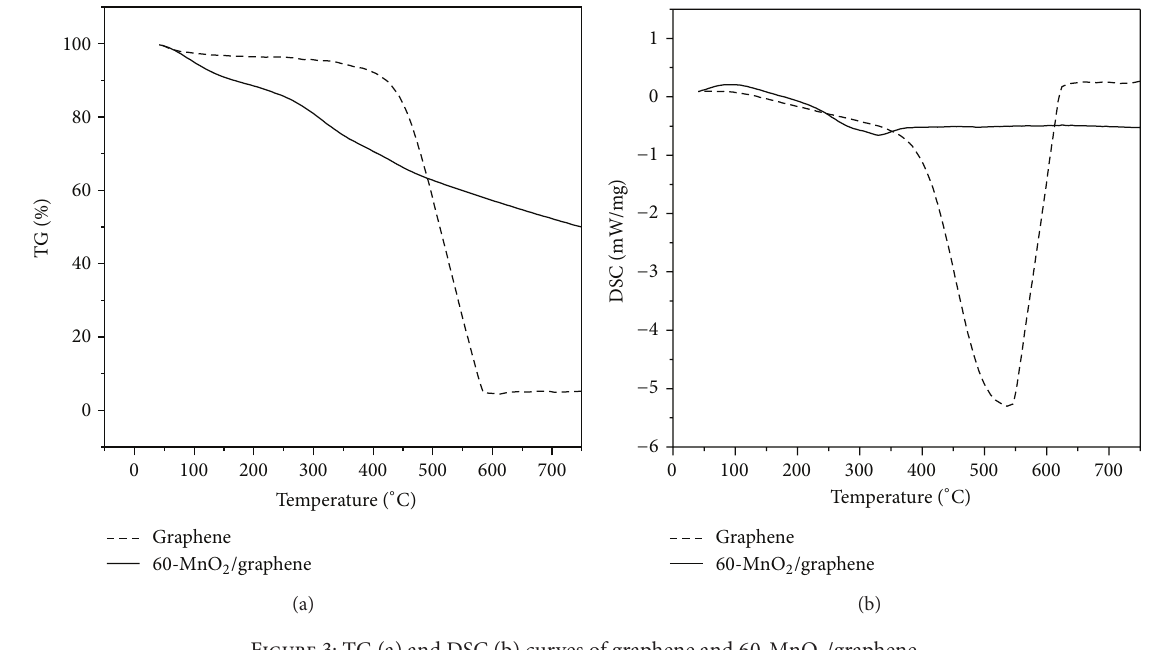
Figure 3: TG (a) and DSC (b) curves of graphene and 60-MnO 2 /graphene.